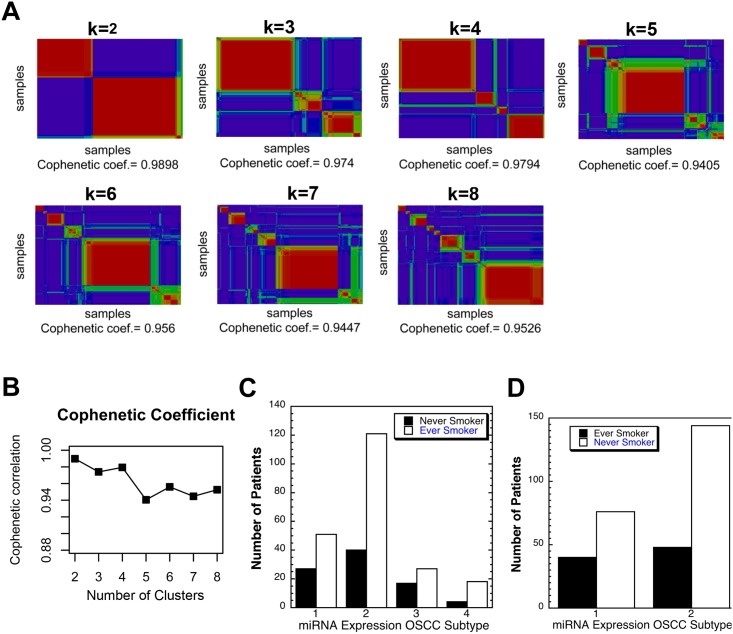
Discovery of OSCC subtypes based on miRNA expression among 305 OSCCs in the TCGA dataset.A) Nonnegatiive matrix factorization consensus clustering showed support for two and four OSCC subtypes based on the maximal cophenetic value at K = 2 and 4. B) Consensus matrices for the samples were calculated at k = 2, 3, 4, 5, 6, 7, 8. A comparison of the visualized consensus matrices allowed a visual assessment of the best rank. Clear block patterns along the diagonal of the consensus matrices indicated robustness of the clustering. C) Analysis of the ever smokers and never smokers in both miRNA based subclass revealed a lack of a difference in the proportions of the two risk groups based on smoking experience, p < 0.059 by Fisher Exact Test D) Analysis of the ever smokers and never smokers in each of 4 miRNA based subclasses revealed no significant difference in proportions of ever and never smokers in any group.